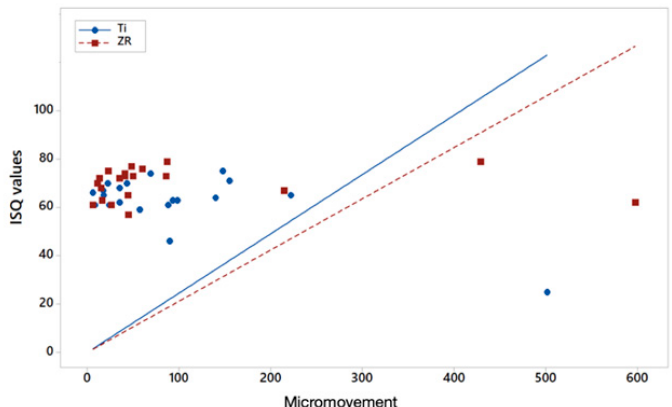
Figure 7. Scatter plot of ISQ values versus micromovements (µm) for titanium and zirconium im-